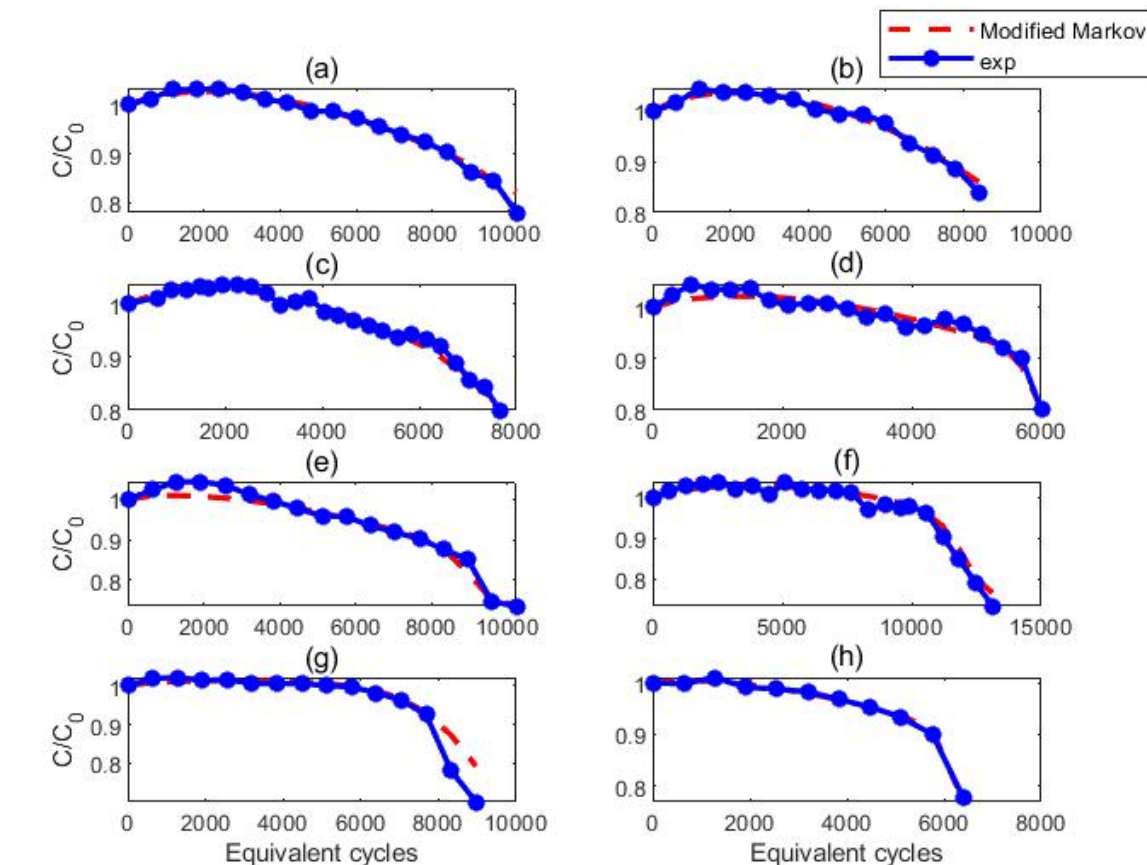
Figure 8. Comparison between the experimental data and the model (8), as a function of the number of equivalent cycles: ( a ) battery number 1; ( b ) battery number 2; ( c ) battery number 3; ( d ) battery number 4; ( e ) battery number 5; ( f) battery number 6; ( g ) battery number 7; ( h ) battery number 8.